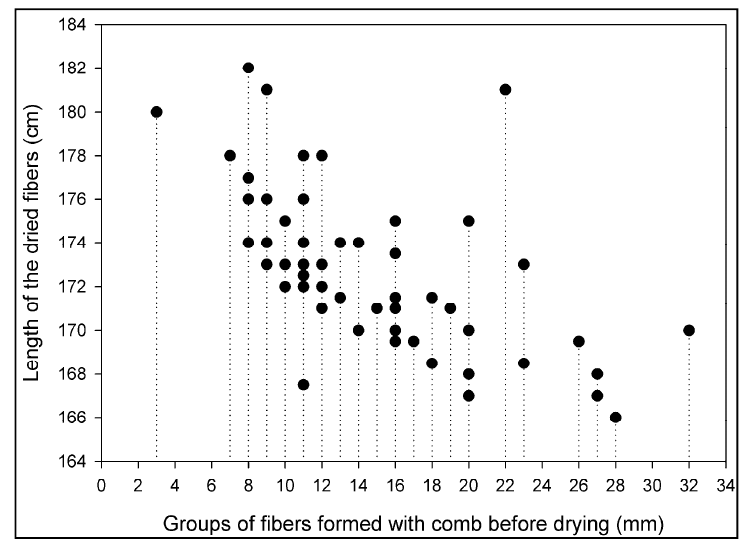
Figure 11. Drying effect on the bundle size of the cellulose fibers.